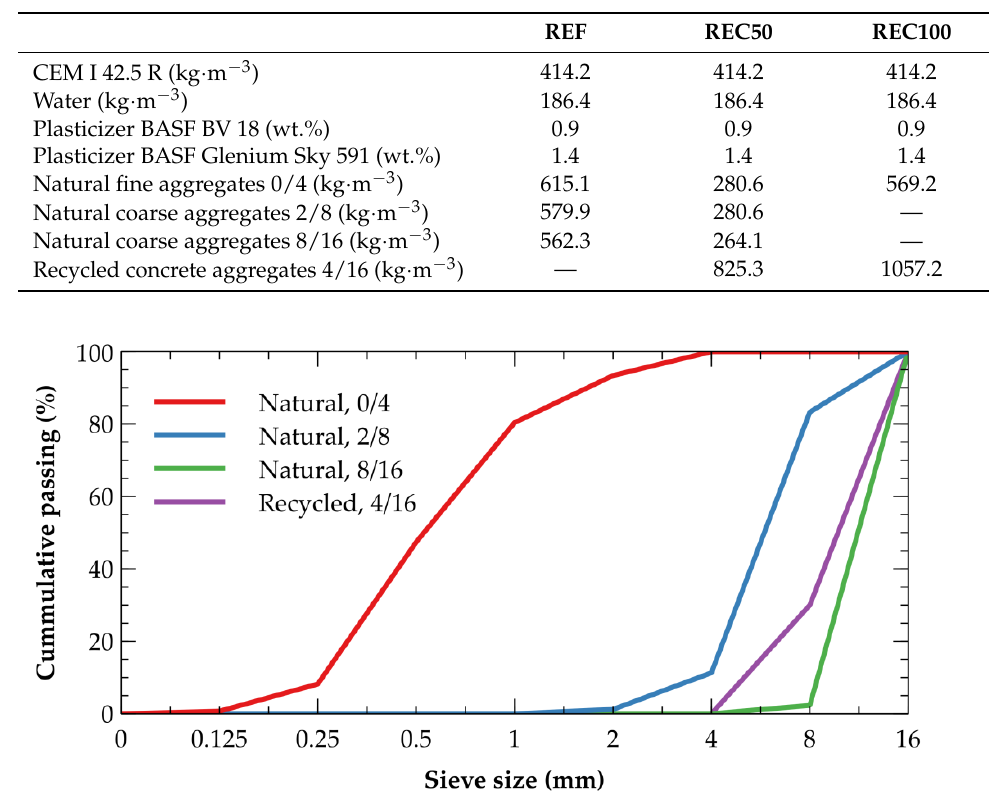
Figure 1. Particle size distribution curves of the aggregates used. Recycled aggregate was made simply by crushing the concrete pavement blocks that were dismounted after exploitation period of 15 years (see Figure 2). The only modifica- tion was the sieving to achieve the particle size range demanded.